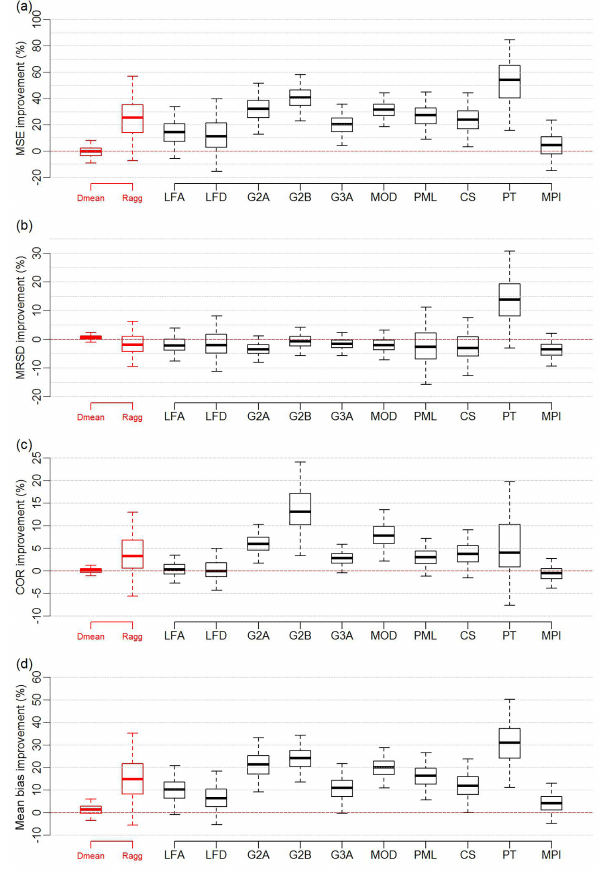
Figure 11. Box and whisker plots displaying the percentage im- provement that the weighting provides when MPIBGC is excluded from the weighting ensemble in the 25% out-of-sample sites test for four metrics: MSE (a) , MRSD (b) , COR (c) and mean bias (d) , when compared to the equally weighted mean ( D mean ) of the di- agnostic ensemble, aggregated reference ensemble ( R agg ) and each member of the reference ensemble. Box and whisker plots represent 5000 entries; each entry is generated through randomly selecting 25% of sites to be out of